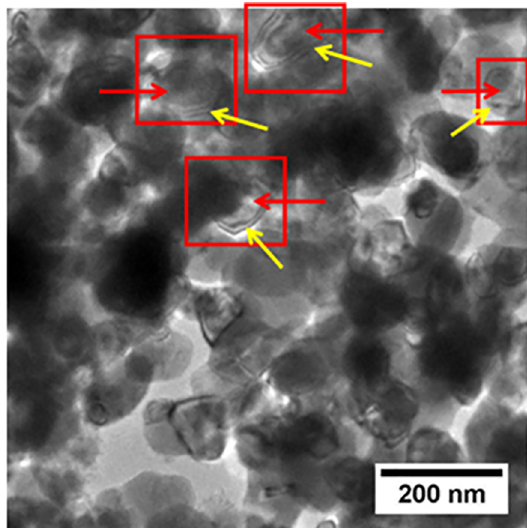
Figure 7. Transmission electron microscopy images for the CS-400 sample. The red arrows represent the FeCo alloy while the yellow O phase (magnetite doped with Co). ones represent the (Fe,Co) 3 4